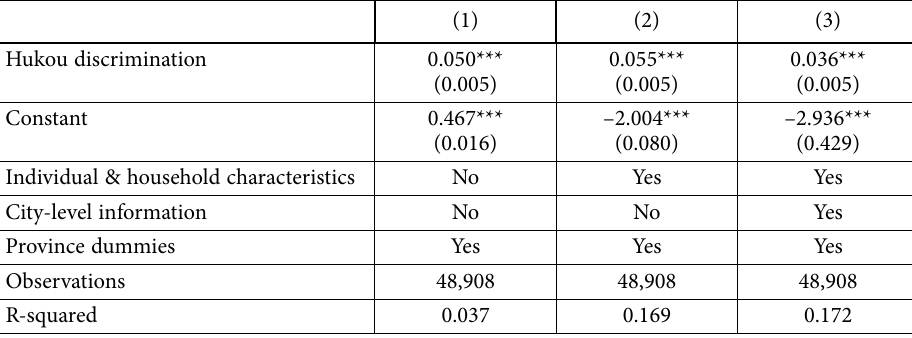
Table 4. Hukou discrimination and entrepreneurship: regional heterogeneity (sample of rural